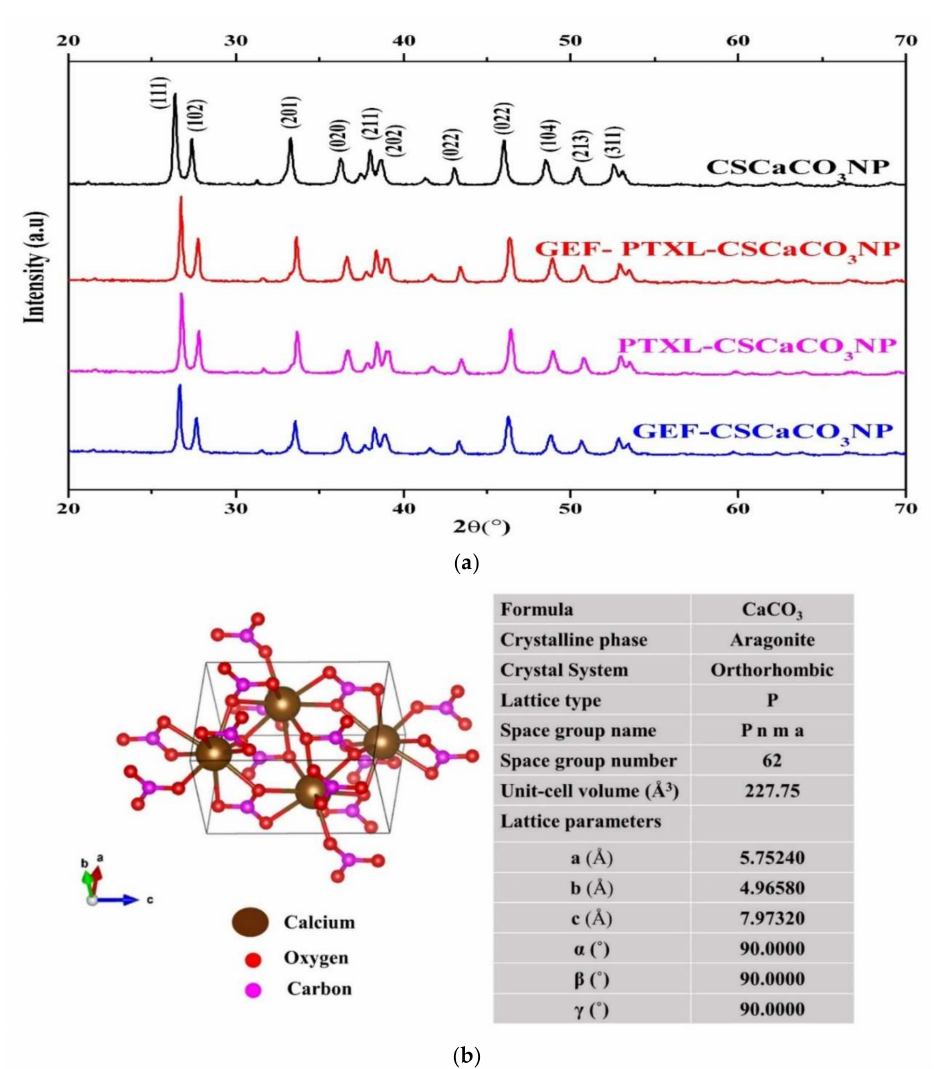
Figure 4. Powder X-ray diffractograms (XRD): ( a ) XRD patterns of CSCaCO 3 NP, GEF-PTXL- CSCaCO 3 NP, GEF-CSCaCO 3 NP, and PTXL-CSCaCO 3 NP. Labelled are the miller indices (h, k, l) planes indicating the peaks of the aragonite crystalline phase; ( b ) Orthorhombic crystalline morphol- ogy of the synthesized aragonite CSCaCO 3 NP along with its lattice